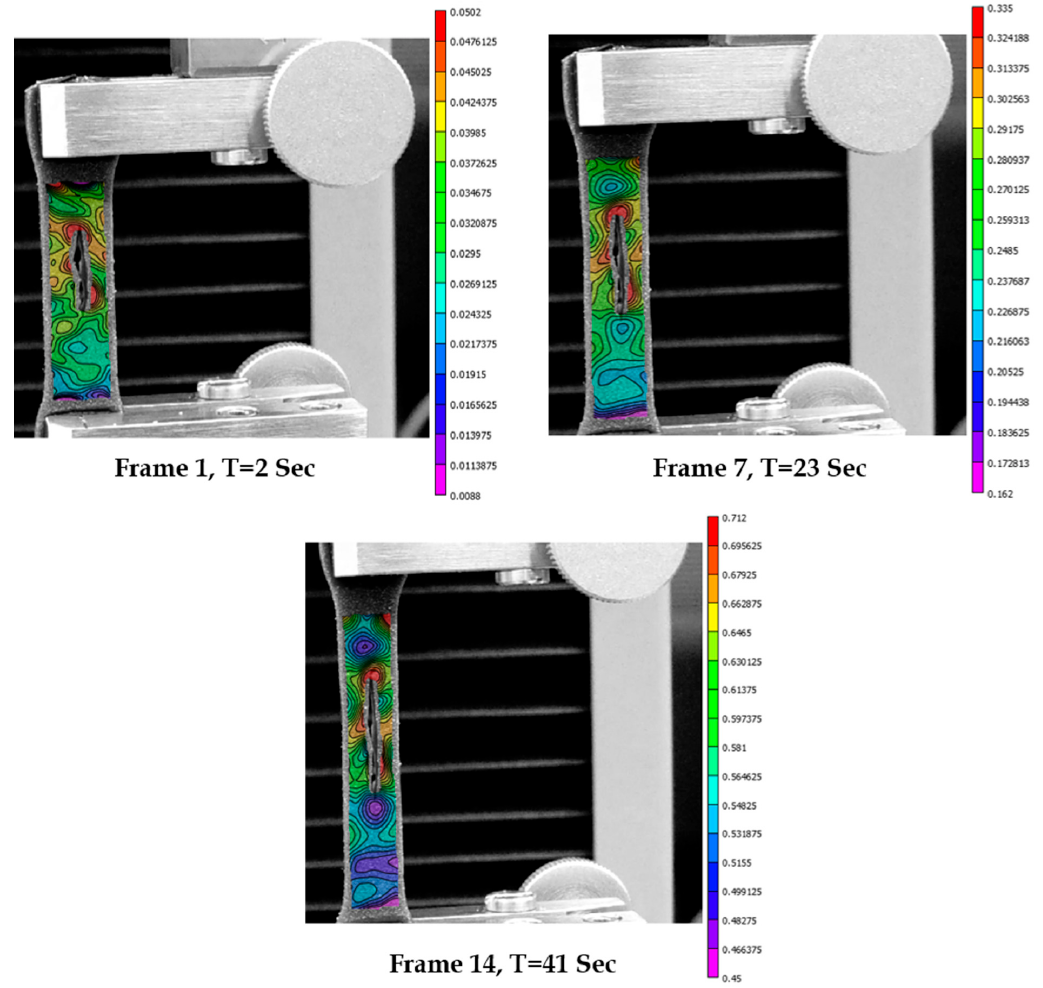
Figure 14. Strain distribution at different times for thin wound 4 measured using DIC.